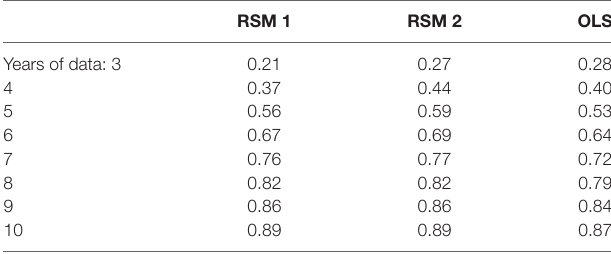
tABLe 1 | The mean correlations between the estimated slope and the true underlying